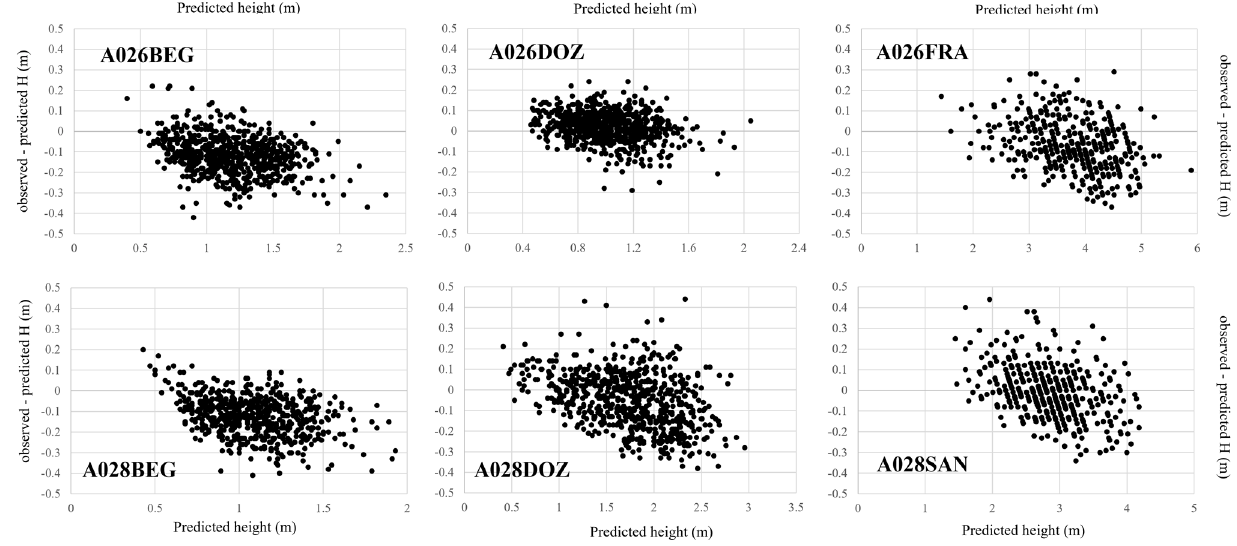
Figure 3. Residual plots (difference between the field measured value and the estimated value through LiDAR) in the six plots analyzed.